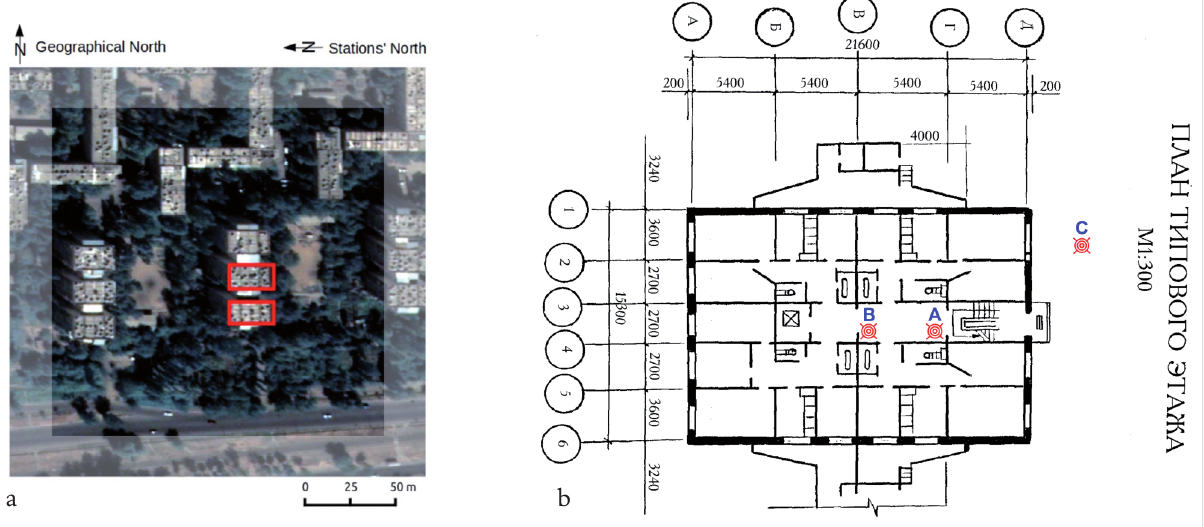
Figure 7. (a) Satellite image and (b) building floor plan of the 9 story reinforced large panel precast concrete building (Figure 2,V), showing the locations of the installed stations (red